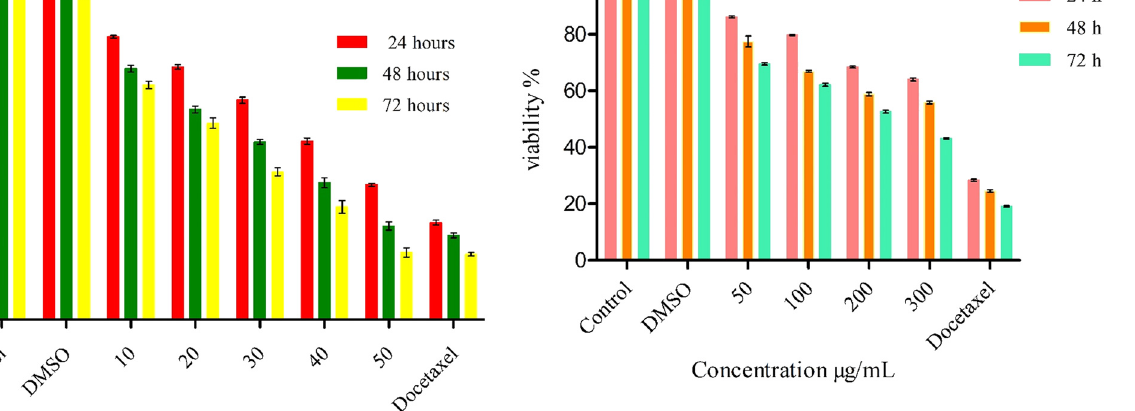
Figure 2: E ff ect of Equisetum arvense essential oil on the viability of LNCaP cells. The viability percentage was measured using MTT assay. LNCaP cells were treated with di ff erent concentrations of the extract for 24, 48, and 72 h.